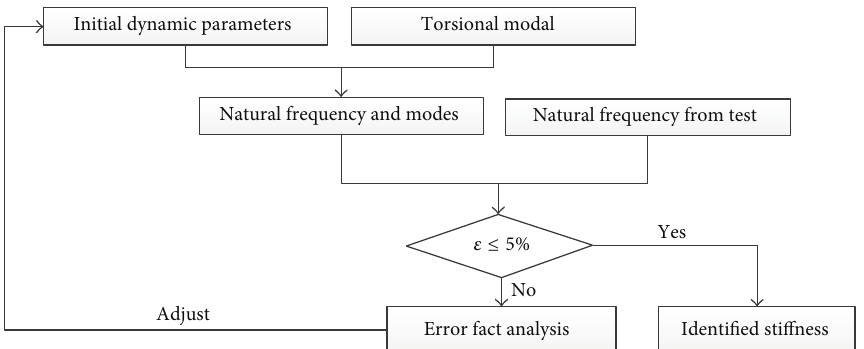
Figure 6: Stiffness identification process online.